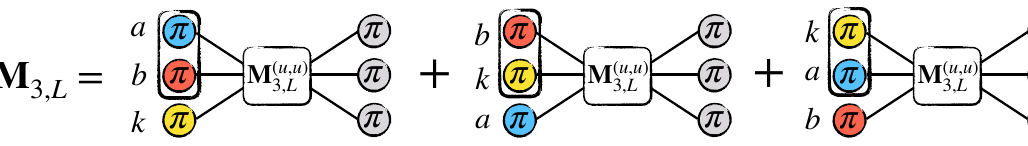
Figure 3 . Representation of the symmetrization procedure applied to the outgoing particles. Colors indicate di(cid:11)erent